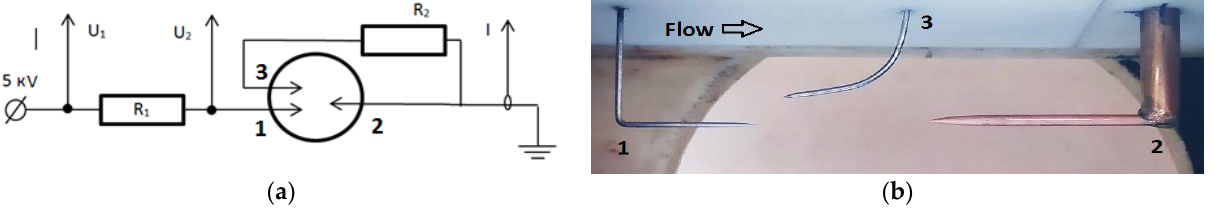
Figure 1. ( a ) Scheme of discharge supply and electrical measurements. ( b ) The geometrical configuration of electrodes. 1 — upstream, 2 — downstream, and 3 — initiating electrode.